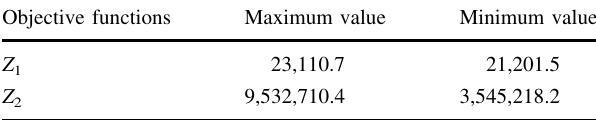
Table 7 The minimum and the maximum values of the objective functions in the robust skip-stop scheduling model Objective functions